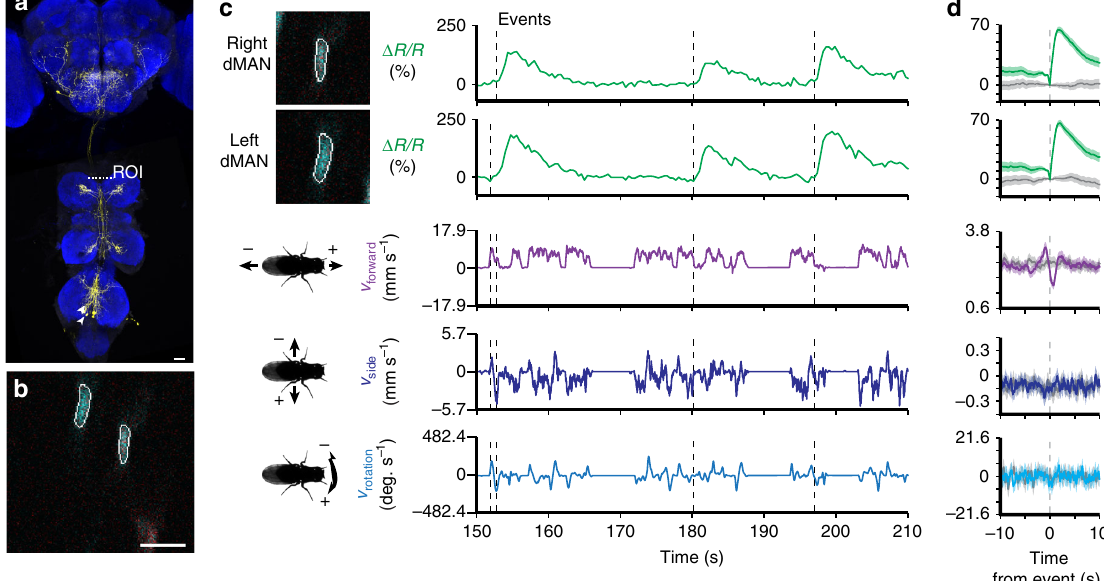
Fig. 3 Neural activity of dMANs in the thoracic cervical connective during behavior. a Confocal image of MAN-Gal4 driver line expression in the brain and VNC. Scale bar is 40 µ m. Neuronal GFP (yellow) and neuropil (nc82, blue) are labeled. A dashed white line highlights the thoracic x – z plane imaged. b Coronal section of the thoracic cervical connective in an animal expressing GCaMP6s (cyan) and tdTomato (red) in MANs ( MAN> GCaMP6s; tdTomato ). Scale bar is 3.5 µ m. c Separated ROIs (top-left) and associated fl uorescence signals from right and left dMANs (top-right). Corresponding forward, sideways, and rotational velocities of the fl y (bottom-right). Events are indicated as dashed gray lines. d Summary of dMAN activity and spherical treadmill rotations with respect to fl uorescence events (748 left neuron and 746 right neuron events) aligned to 0 s (dashed gray line). Control data in which events are time-shuf fl ed are overlaid in gray. Shown are the means (solid line) and bootstrapped 95% con fi dence intervals